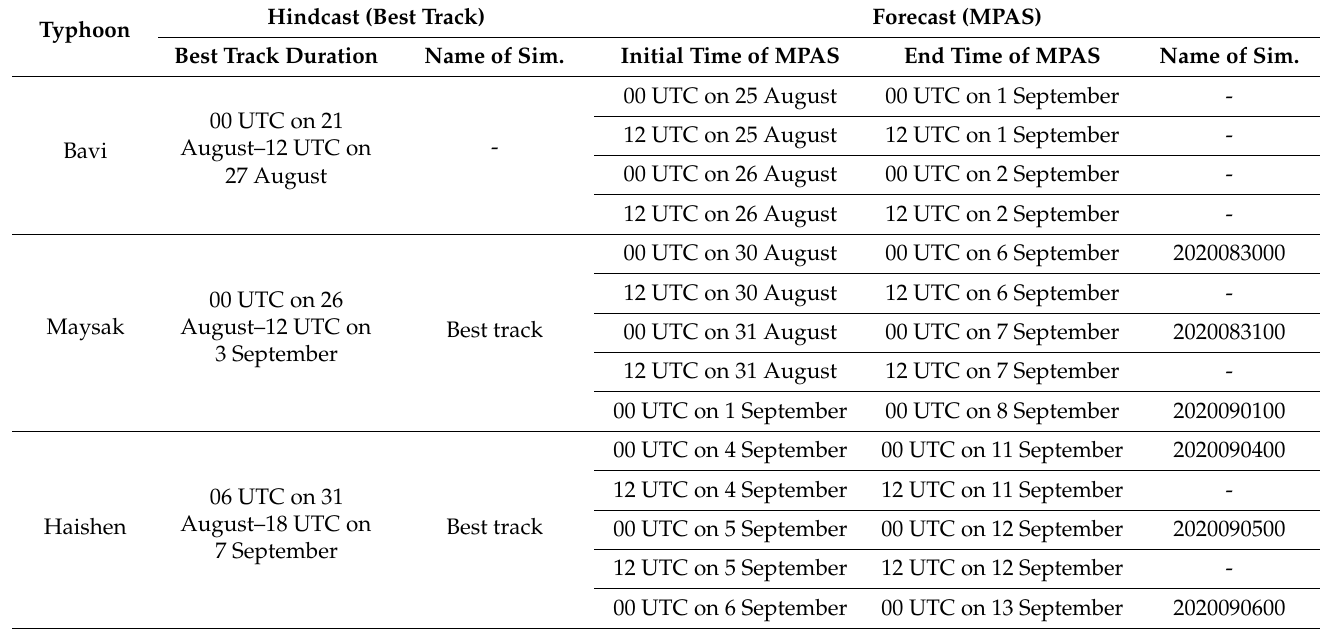
Table 2. Three selected typhoons in 2020 and their hindcast/forecast simulation cases and periods. Hindcast (Best Track) Forecast (MPAS) Typhoon Best Track Duration Name of Sim. Initial Time of MPAS End Time of MPAS Name of